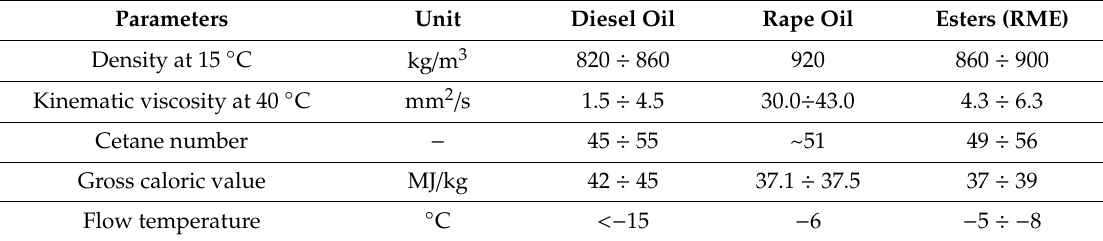
Table 2. Comparison of some parameters of diesel oil, rape oil, and methyl ester of higher acid of rape oil (RME)